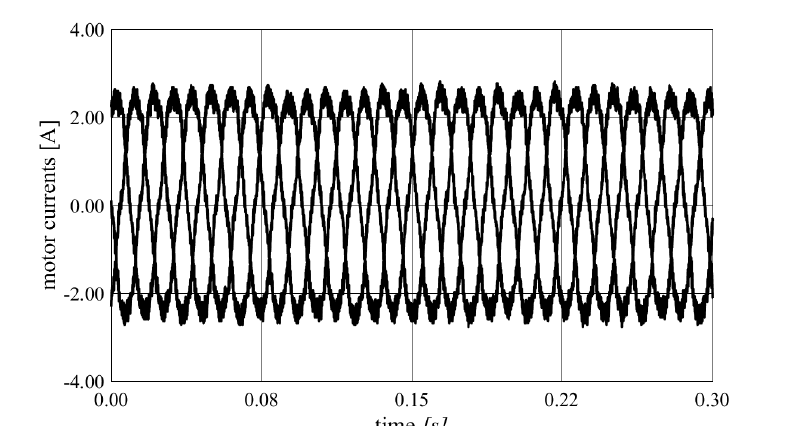
Figure 16. Experimental result: motor currents achieved with the proposed SVM based on Equation (22), when m = 0.94, v ∗ = v ∗ = 200 V, and T l = 3.5 Nm. C1 C2